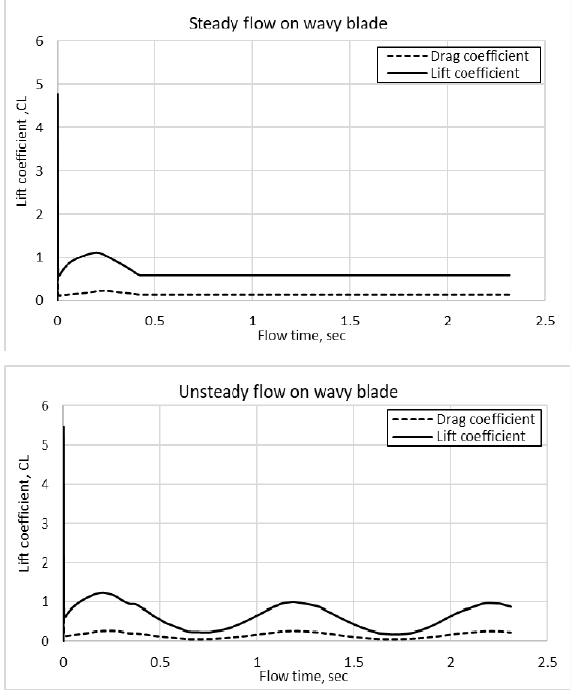
Figure 7. Lift coefficient history at AOA=12 0 for the steady and unsteady wind